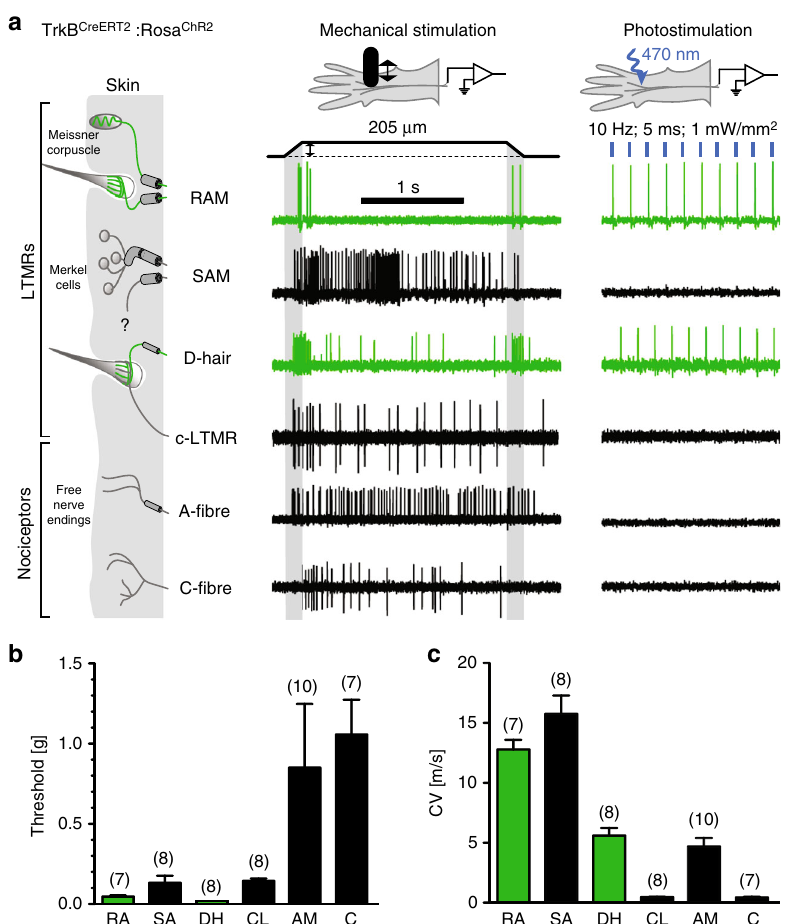
Fig. 2 TrkB-positive sensory neurons are myelinated low-threshold mechanoreceptors. In vitro skin nerve preparation from TrkB CreERT2 ::Rosa26 ChR2 mice showing a representative responses to 10 Hz stimulation with blue light, b the minimal force required to elicit an action potential in the indicated fi ber type, and c the conduction velocities of the fi ber types. Green bar represents TrkB + afferents, n number indicated in brackets. Error bars represent